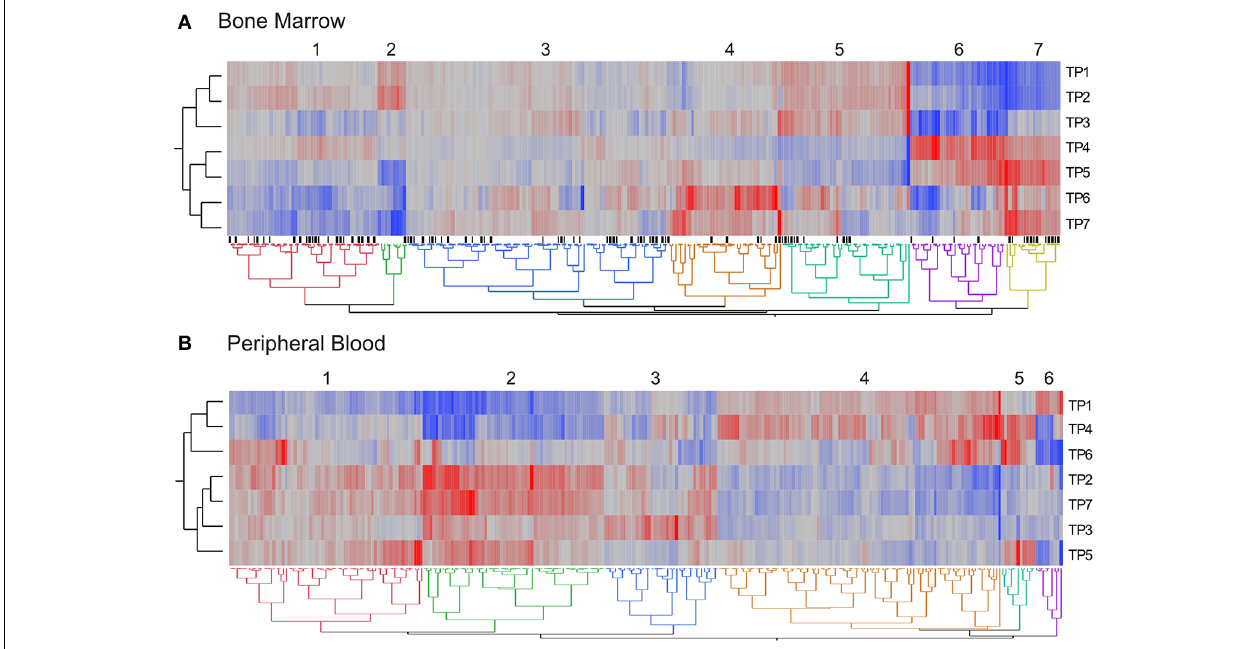
FIGURE 6 | Differential representation of pathways across timepoints. The two-way hierarchical heat maps summarize co-expression of genes within pathways in the bone marrow (A) and peripheral blood (B) . Data points are the mean PC1 score for each of 270 KEGG pathways. Rows